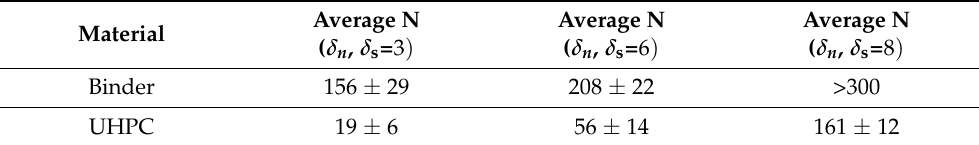
Table 5. Average lifetime of UHPC and binder in fatigue simulations with varied damaging factors δ n , δ s